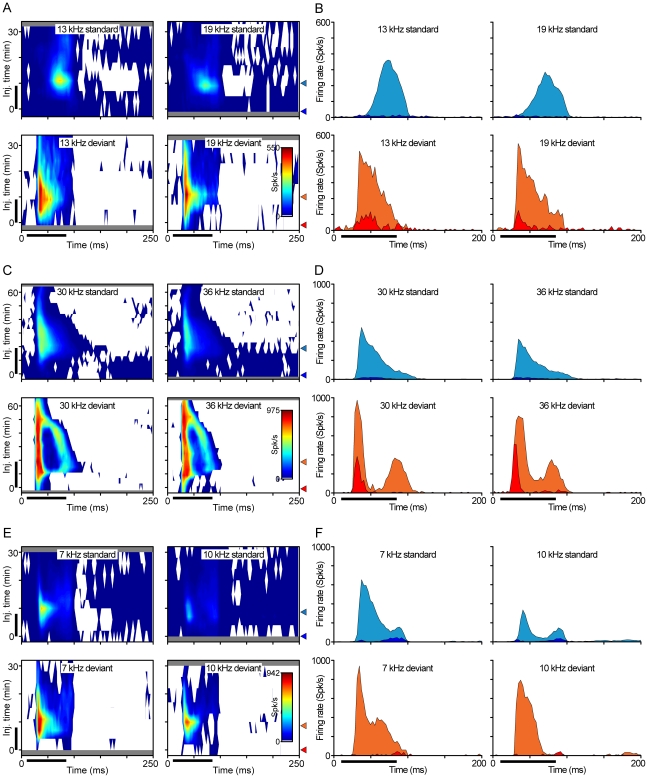
Effect of gabazine on response patterns.(A, C, E) Evolution of the response pattern (abscissa) during the course of the experiment (ordinate), for 3 representative neurons. Each contour plot shows the response of the neuron (color-coded, see scale) for each of the stimuli (columns) and each of the probability conditions (standard, top row; deviant, lower row). The horizontal black bar indicates the duration of the stimulus, while the vertical black bar indicates the application of gabazine. Note that the responses are very similar between frequencies, while they differ depending on the probability of the stimulus. The grey areas in the plots relate to the times when there is no data available for the corresponding frequency and probability, due to the stimulation sequence. (B, D, F) Representative PSTHs (filled areas) for each of the stimuli (columns) and probability conditions (standard, top row; deviant, lower row), before (blue, standard; orange, deviant) and during the application of gabazine (light blue, standard; light red, deviant). The approximate times of these histograms are indicated by triangles on the right of each set of contour plots. Bin size of the PSTHs is 3 ms.